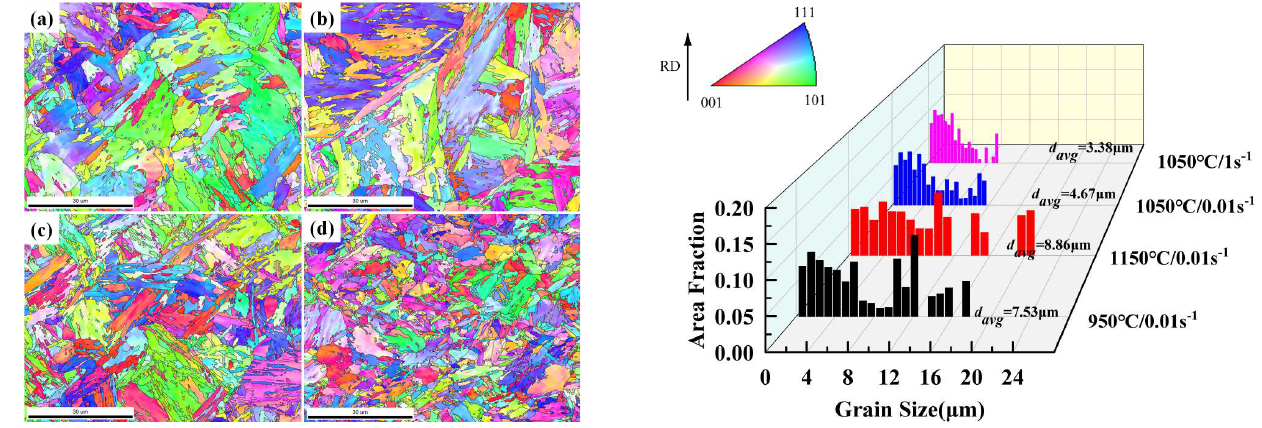
Figure 6. IPF maps of 18CrNiMo7-6 alloy steel ( a ) 950 °C/0.01 s −1 ; ( b ) 1150 °C/0.01 s −1 ; ( c ) 1050 °C/0.01 s −1 ; ( d ) 1050 °C/1 s −1 .